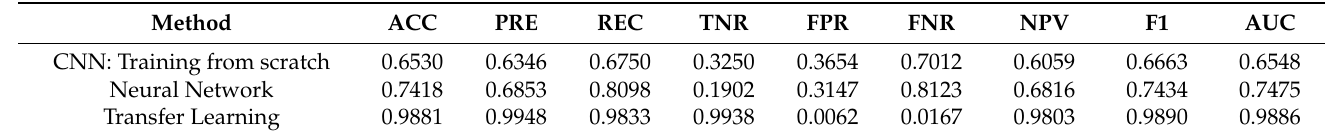
Table 6. Classification metrics when applying alternative learning